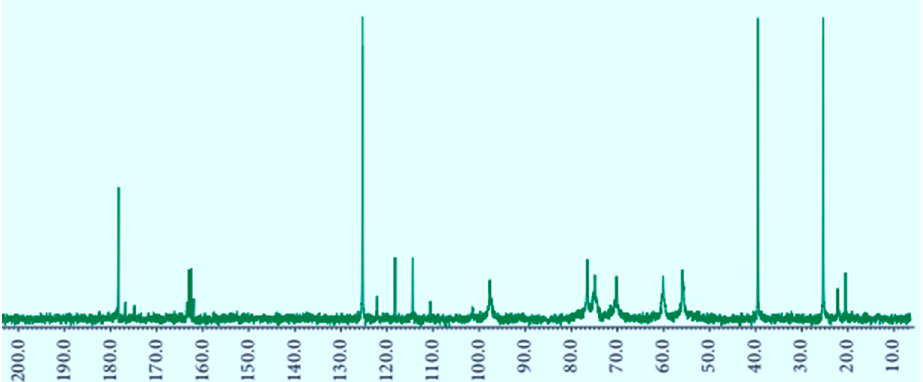
Figure 3. 13 C-NMR spectra of CS-FUAC.